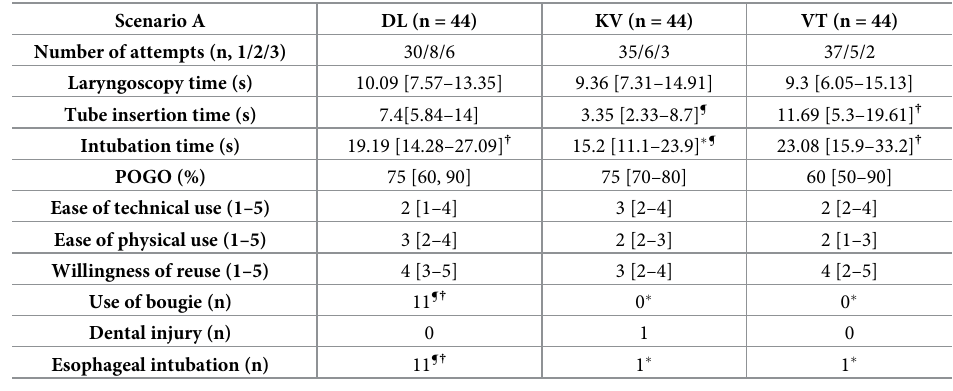
Table 1. Results of “Scenario